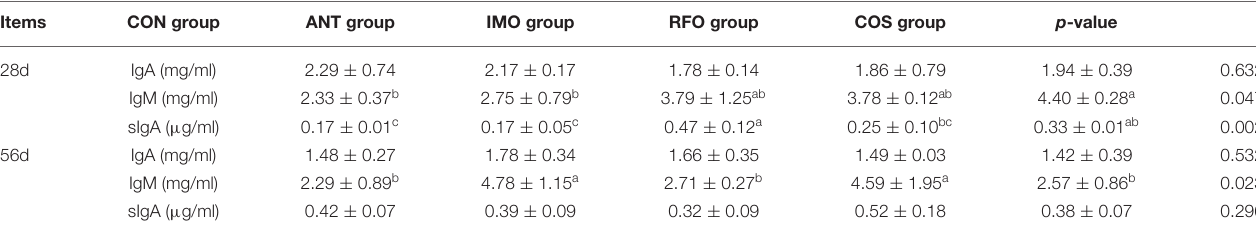
TABLE 4 | Effects of different oligosaccharides on serum IgA, serum IgM, and secretory IgA levels in broilers.